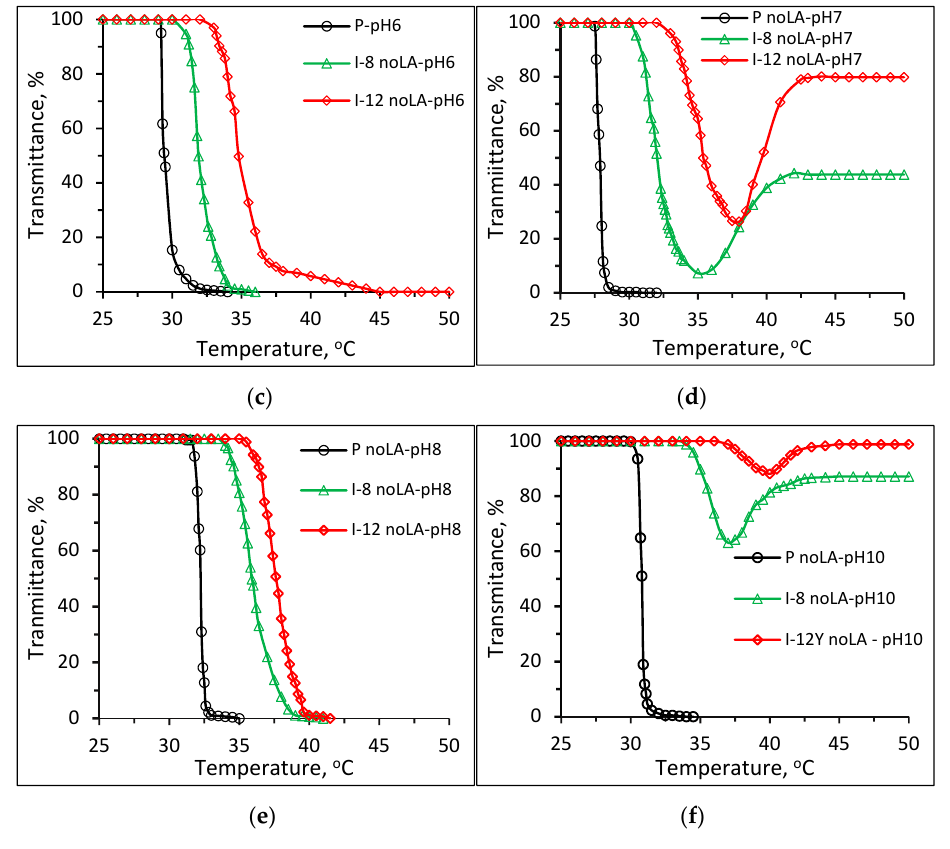
Figure 5. Plots of transmittance vs. temperature of 1 wt % aqueous solutions of Pnipam and P(nipam-co-IAM) synthesized without stereo-control in buffer solutions of ( a ) pH = 4, ( b ) pH = 5, ( c ) pH = 6, ( d ) pH = 7, ( e ) pH = 8 and ( f ) pH = 10.